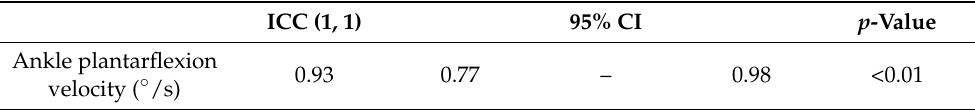
Table A3. The intraclass correlation coefficient for the test-retest